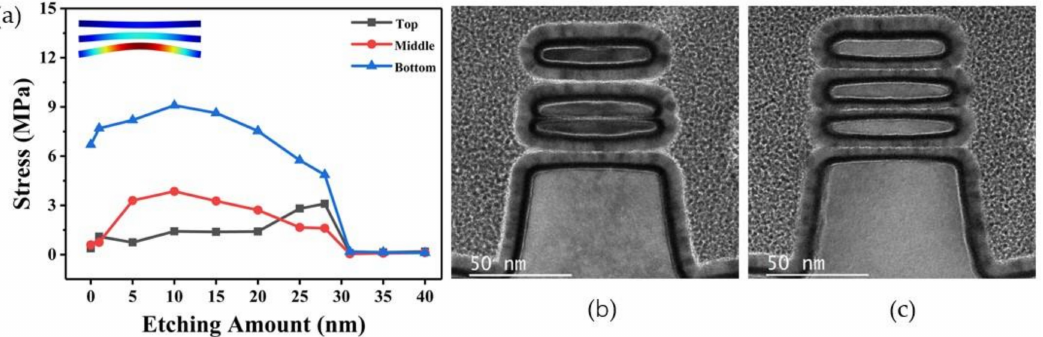
Figure 3. ( a ) The stress evolution on the 60 nm-wide nanosheets along with the increasing etching amount of the SiGe layers. Inset: The deformation of the nanosheets caused by the maximum stress values obtained by finite element simulation. TEM cross-sectional images of 60 nm-wide stacked nanosheets obtained by ( b ) single-step etching and ( c ) multi-step